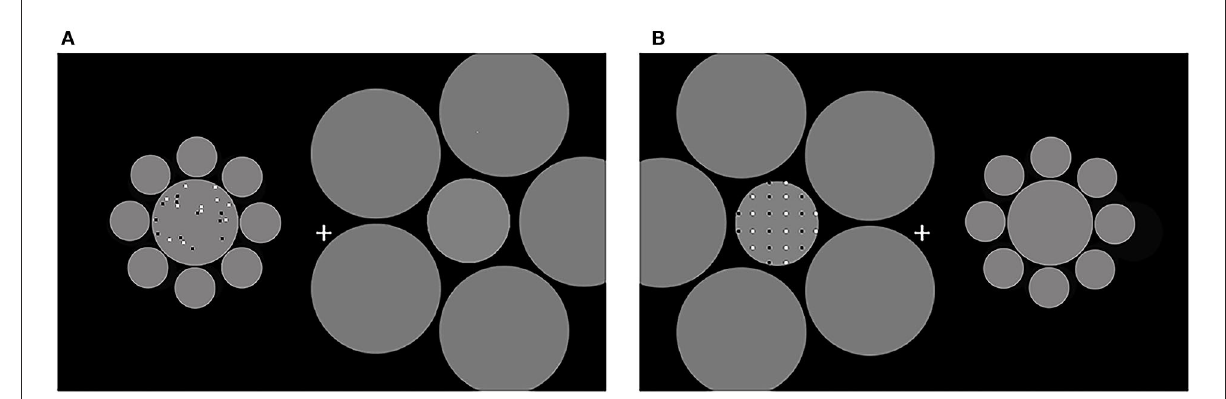
FIGURE1 The stimuli used in the current study. Reference in the random and the regular conditions are shown. Reference and test patterns were displayed sequentially, each in one patch. To induce the Ebbinghaus area illusion, the patches were surrounded by larger and smaller circles, respectively. (A) A sample for random patterns; (B) a sample for regular patterns. The positions of references and tests were counterbalanced across